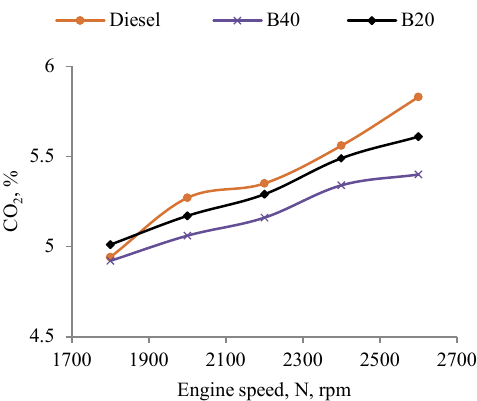
Fig. 11. CO 2 emission in diesel engine for diesel and biodiesel blends.